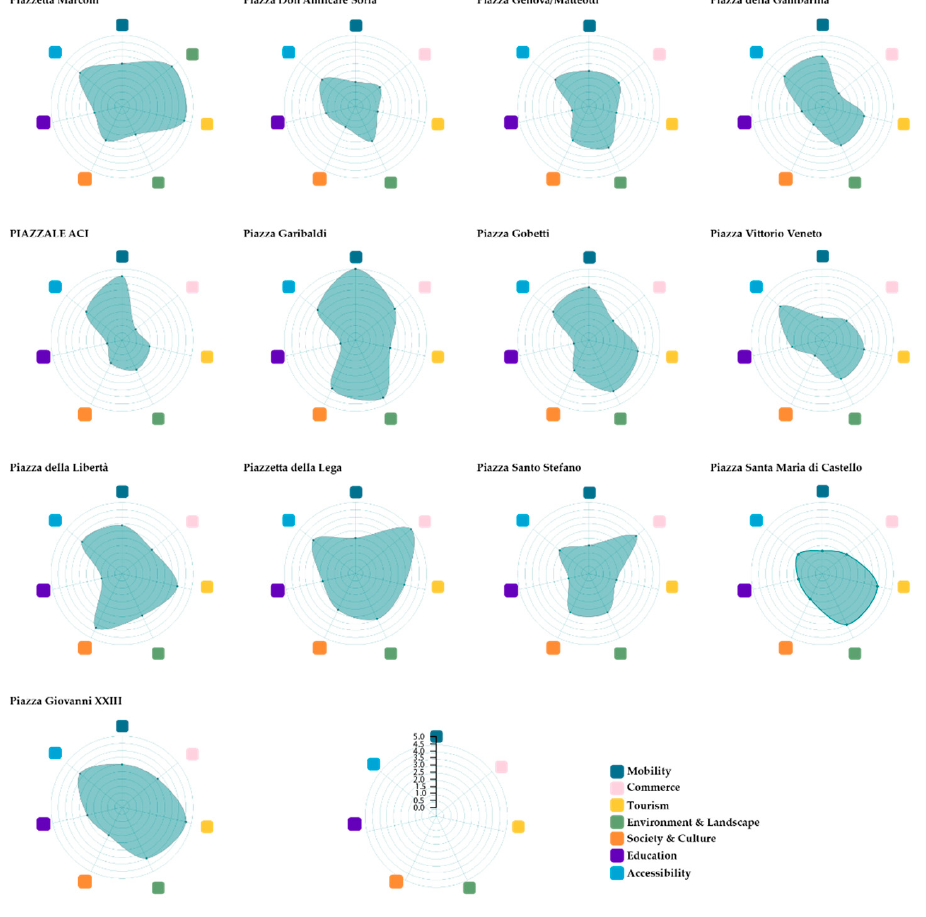
Figure 7. The polar diagrams of the 13 squares in order to visualize the synthetic domain rating [Source: Authors].